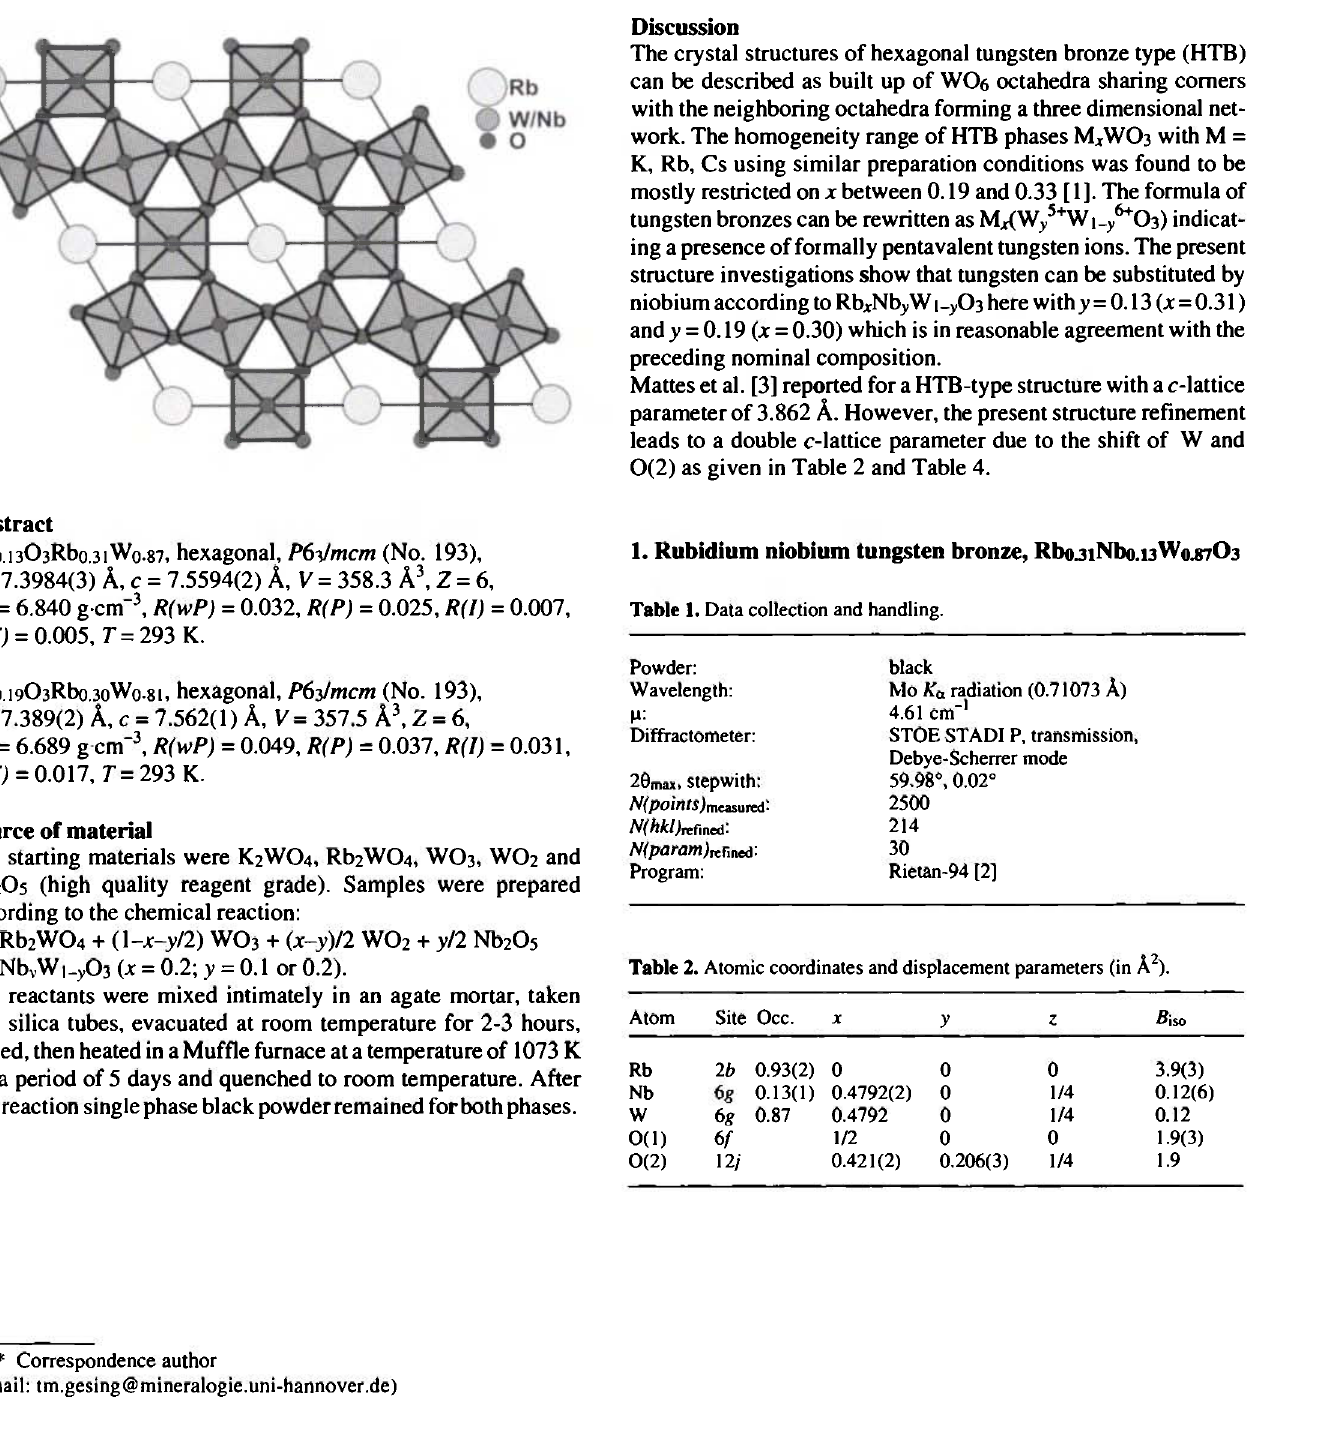
Table 2. Atomic coordinates and displacement parameters (in Ä 2